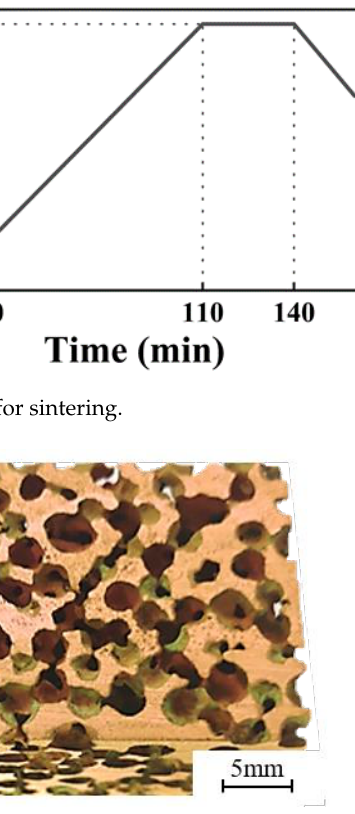
Figure 3. As-built sample.